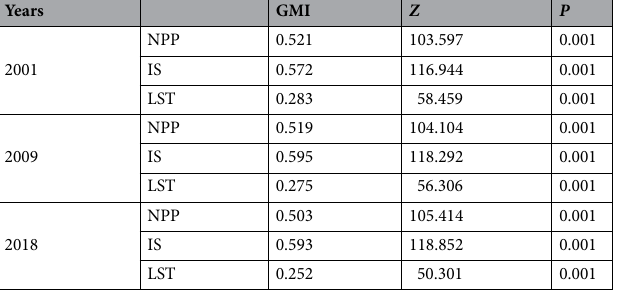
Table 1. The global Moran’s I of NPP, IS and LST in 2001, 2009, and 2018. GMI denotes the globe Moran’s index. Z is the standardized value which denotes the Z -Scores. P is the significance test level value which denotes the P -values. NPP is net primary productivity. IS is impervious surface. LST is land surface